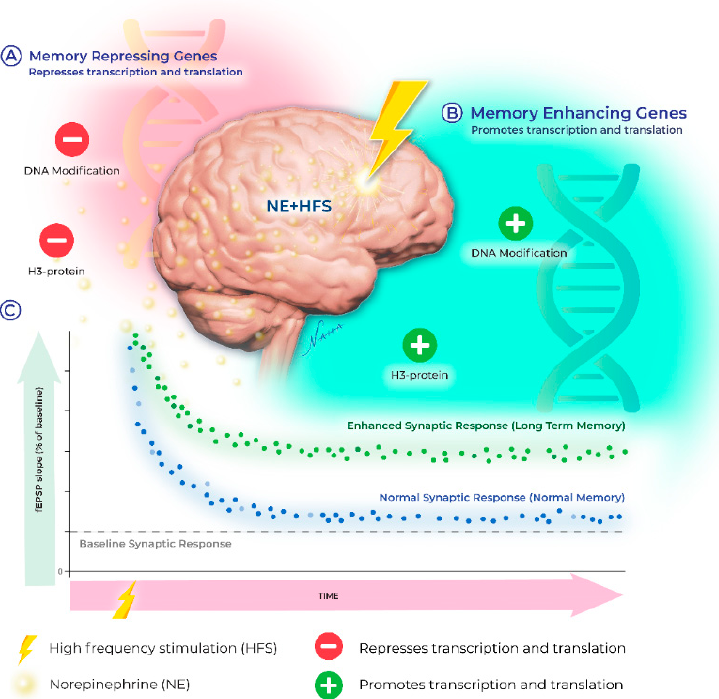
Figure 1. Norepinephrine engages epigenetic mechanisms permissive for plasticity. The presence of NE shifts epigenetic regulation of genes important in memory formation. NE mediated signaling upregulates the epigenetic modifications (such as, DNA methylation and H3-acetylation) of the memory enhancer genes (noted by “B” for the proteins that enhances the synaptic plasticity such as AMPA receptor subunits) but suppresses the activity of the memory repressor genes (noted by “A”). The exact mechanisms are yet to be determined. The bottom figure (C) represents the enhanced field-EPSP slope from the hippocampal CA1 region of the tri-synaptic circuit due to the paired application of NE and high-frequency stimulus (green dotted line) compared to the high-frequency stimulation only (blue dotted line). The enhanced synaptic response in presence of NE may lead to the stabilization of long-term memory. Similarly, short-term memory does not consolidate in absence of the